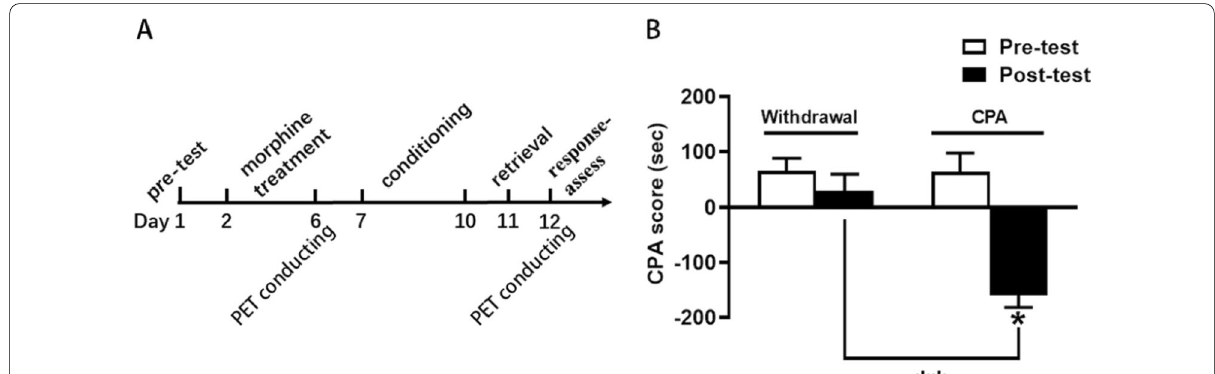
Fig. 3 The establishment of the behavior model. A The timeline of the behavior produced. B The average CPA scores of the withdrawal group and CPA group. * P < 0.005, ** P < 0.0001